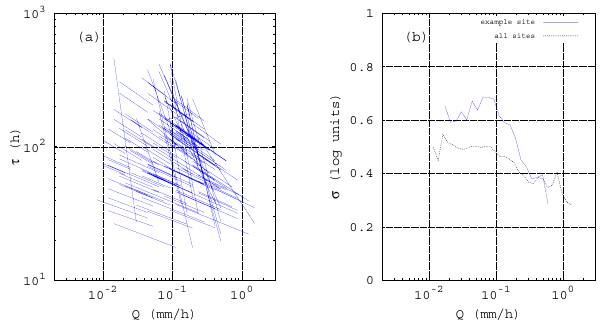
Fig. 9. (a) Scatter of flow recession timescales from power-law curve fits to individual recession limbs over the record period at the example site. (b) Standard deviation σ of the log recession timescale at the example site (solid line) and its median across all sites (dashed